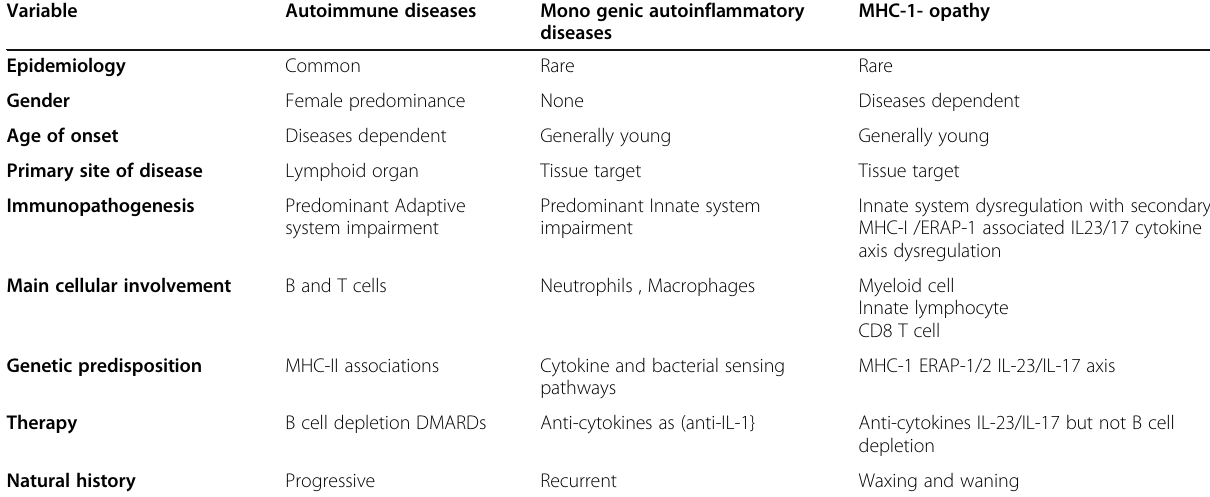
Table 4 The main differences between autoimmune, monogenic autoinflammatory disorders and (major histocompatibility complex)-I associated disorders [20]